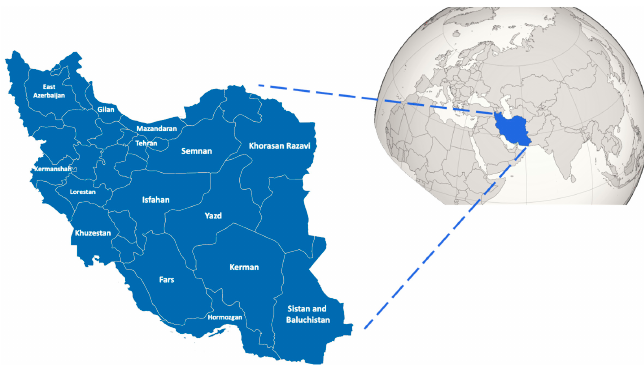
Figure 1. The location of the study area—Iran and its provinces.